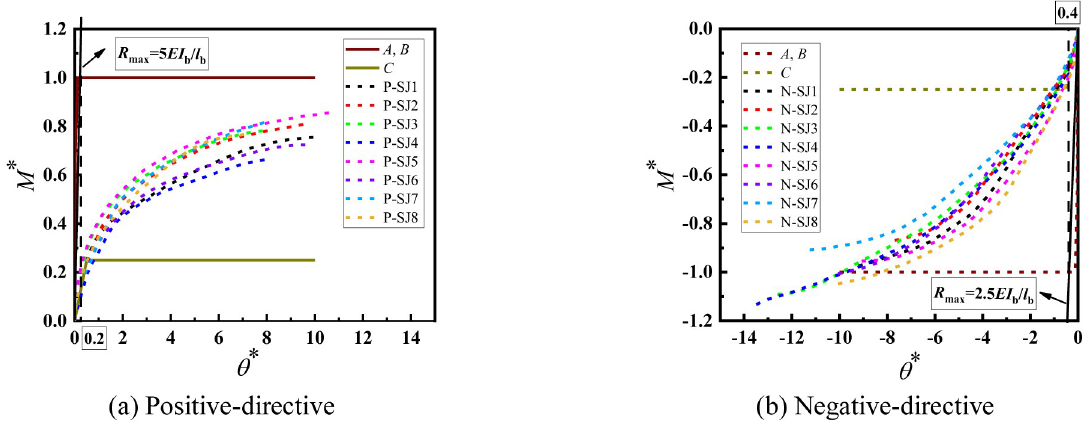
Fig 13. Diagram of initial bending stiffness of disc-buckle type joints. (a) Positive-directive. (b) Negative-directive.